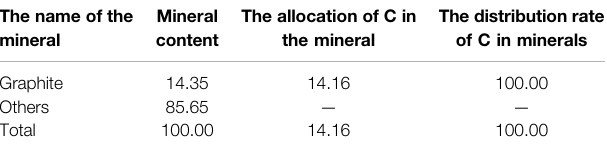
TABLE 3 | Calculation of carbon distribution rate in carbonaceous minerals/%. The name of the mineral